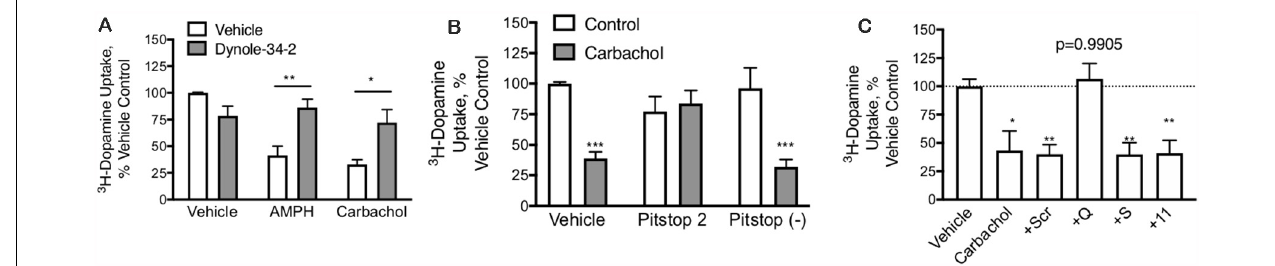
FIGURE 4 | DAT-mediated internalization by carbachol is dependent on both dynamin and clathrin. (A) In primary midbrain cultures, dynole (50 µ M), an inhibitor of dynamin, prevented DAT internalization in response to both AMPH (10 µ M) and carbachol (30 µ M). These data further support the internalization of the transporter as the mechanism of loss of DAT function ( n = 3, * P ≤ 0.05 and ** P ≤ 0.01 by two-way ANOVA). (B) Pitstop II (30 µ M), a clathrin inhibitor, prevents DAT internalization in response to carbachol. There was no affect effect of this clathrin inhibition on AMPH-mediated DAT internalization, consistent with prior studies demonstrating this as a clathrin-independent process ( n = 3, *** P ≤ 0.001 by two-way ANOVA). (C) TAT-fused peptides that were designed to interfere with GPCRs coupled to G Q , G S , or G 11 alpha subunits were applied to dopamine neurons in primary culture (70 µ M). Subsequent treatment of these cultures with carbachol led to the loss of DAT-mediated DA transport under all conditions, except the TAT-G Q pre-treated cultures ( n = 5, * P ≤ 0.05 and ** P ≤ 0.01 by one-way